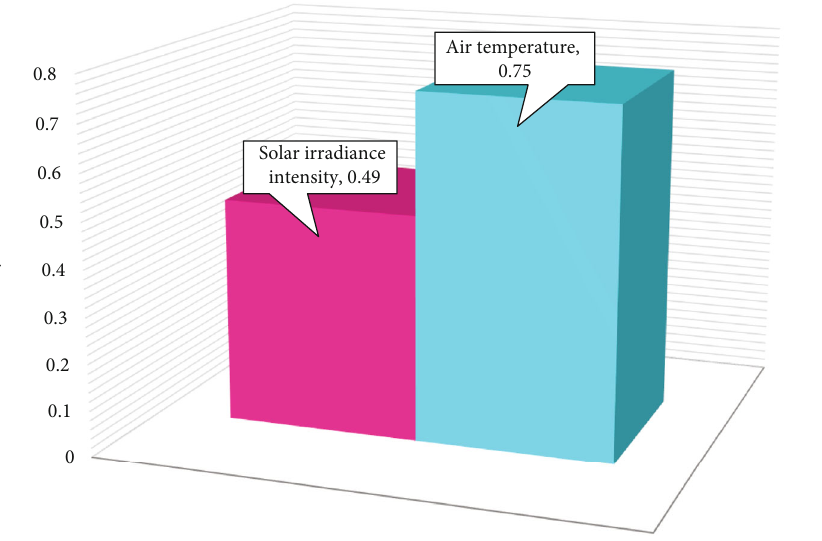
Figure 1: Sensitivity analysis on parameters a ff ecting output.